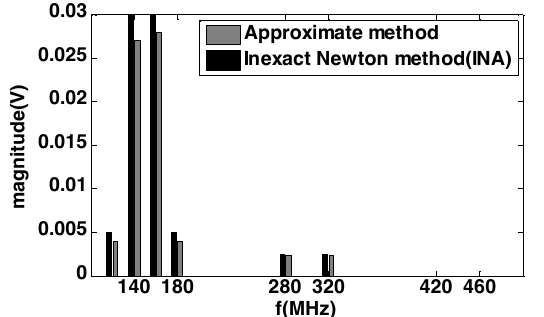
FIGURE 5. The circuit of the dc-biased diode connected to the center of each antenna in the infinite arrays.